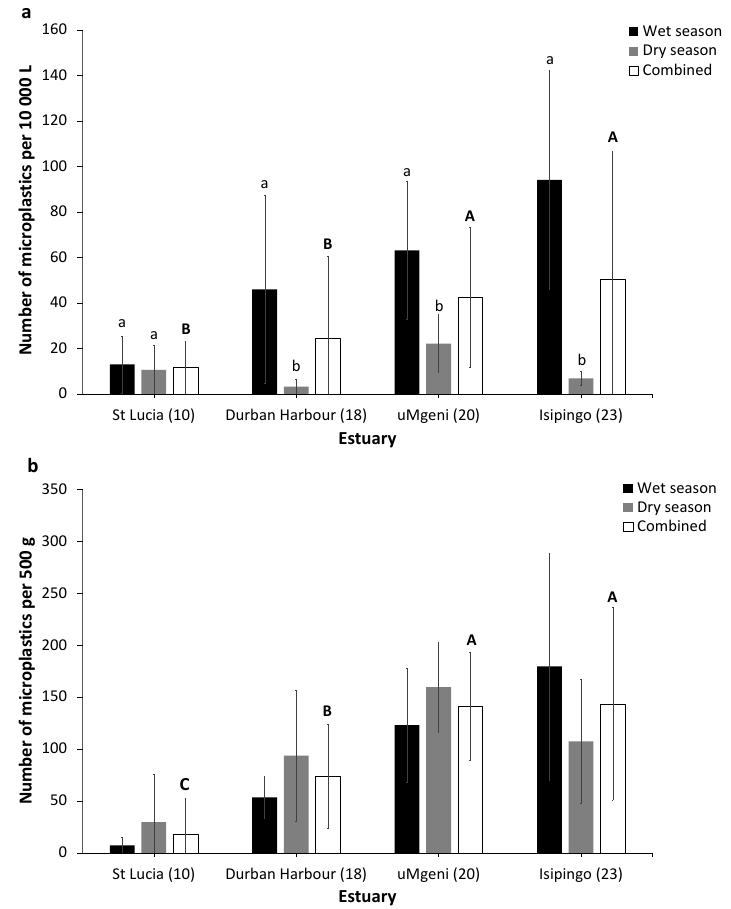
Figure 5. Number of microplastics (mean ± SD) in ( a ) surface water (n = 6 per season) and ( b ) mangrove sediment (n = 9 per season) at the four estuaries sampled in the wet and dry seasons. Uppercase letters indicate significant differences in MP concentrations across estuaries based on combined seasonal data ( p < 0.0001; ANOVA). Lowercase letters indicate significant differences in MP concentrations between seasons within estuaries ( p < 0.0001 for ( a ); no significant inter-seasonal differences (ANOVA) for ( b )). Numbers within brackets on the x-axis represent total disturbance score (TDS) for each estuary.